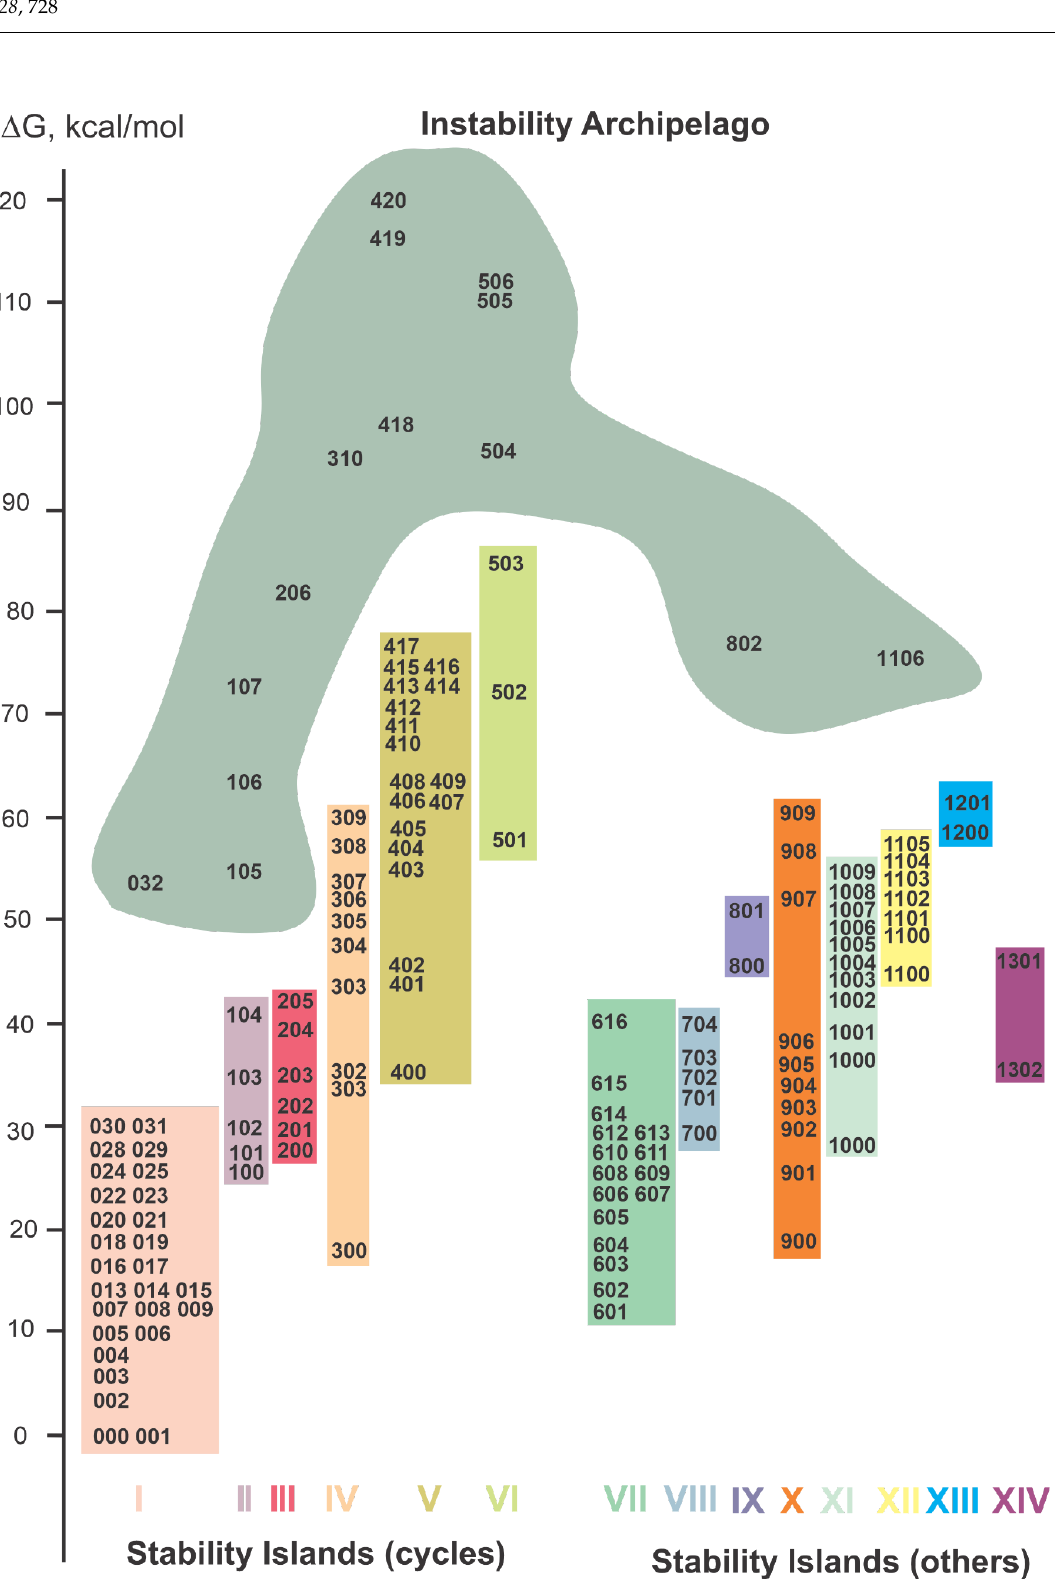
Figure 3. Map of the Gibbs free energies for all located minima for C 4 H 5 NO. I: 5-membered hetero- cycles; II: 6-membered heterocycles; III: 4-membered heterocycles; IV: saturated 3-membered heter- ocycles; V: unsaturated 3-membered heterocycles; VI: bicycles; VII: acyclic nitriles; VIII: conjugated trienes; IX: acetylenes; X: allenes; XI: acyclic isonitriles; XII: carbenes; XIII: bipolar compounds; XIV: molecular associates.